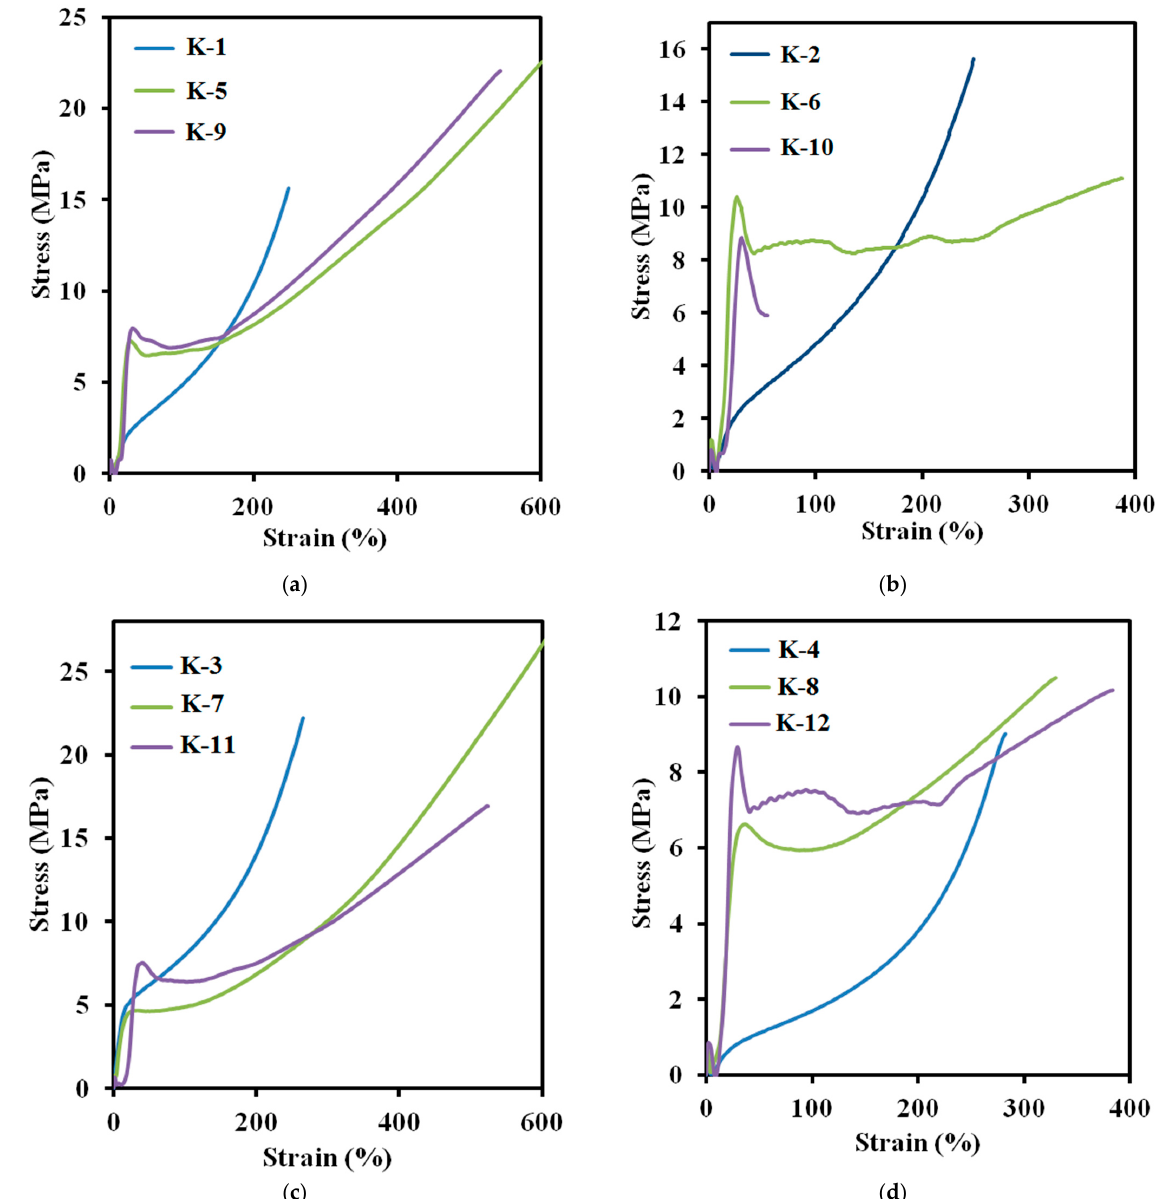
Figure 9 . Stress–strain curves of elastomer samples at 25 ° С : ( а ) K–1, K–5, K–9; ( b ) K–2, K–6,